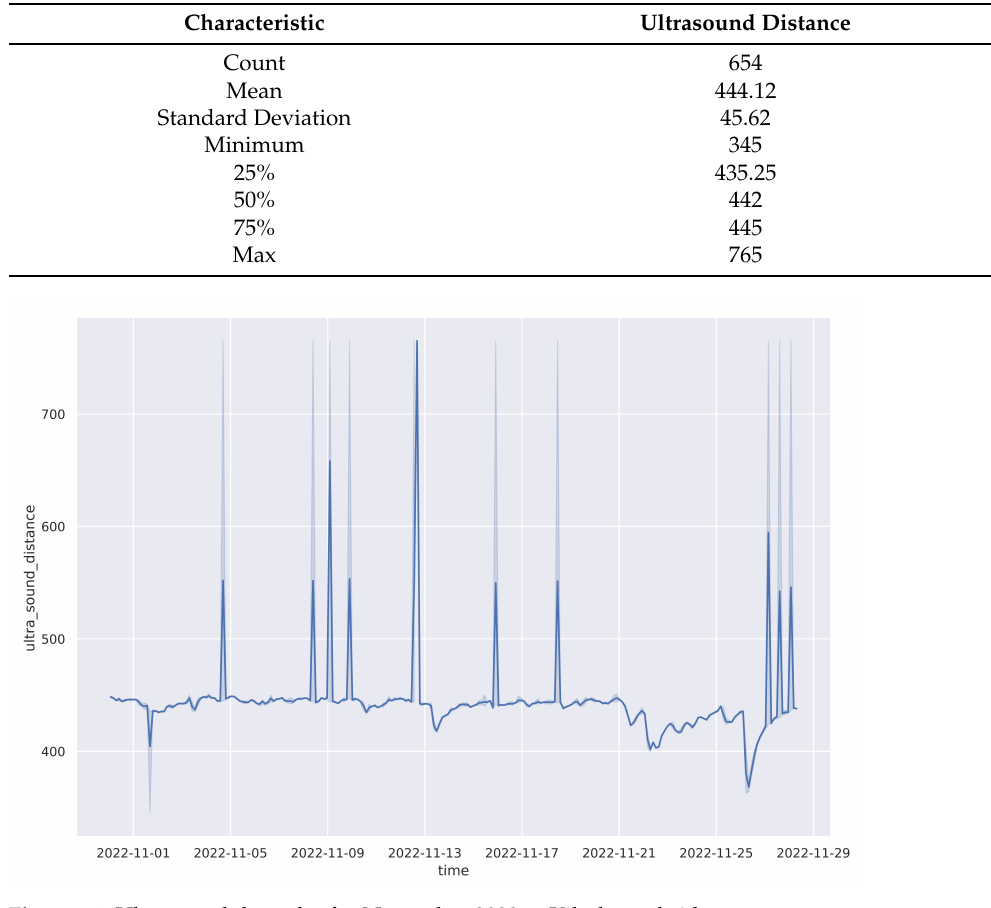
Table 4. Ultrasound distance characteristics for November 2022 at Kikuletwa bridge.